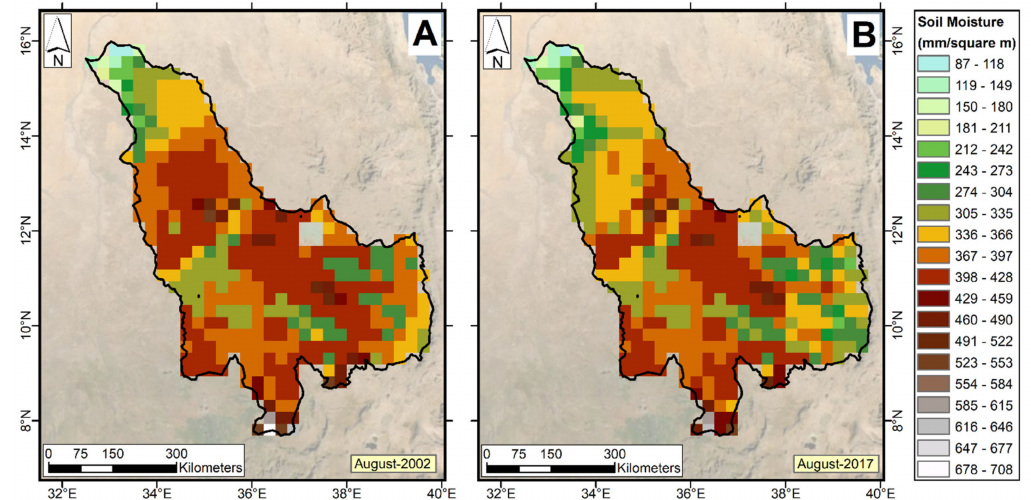
Figure 4. Soil moisture data from GLDAS-Noah v2 for the Blue Nile, ( A ) August 2002; ( B ) August 2017.